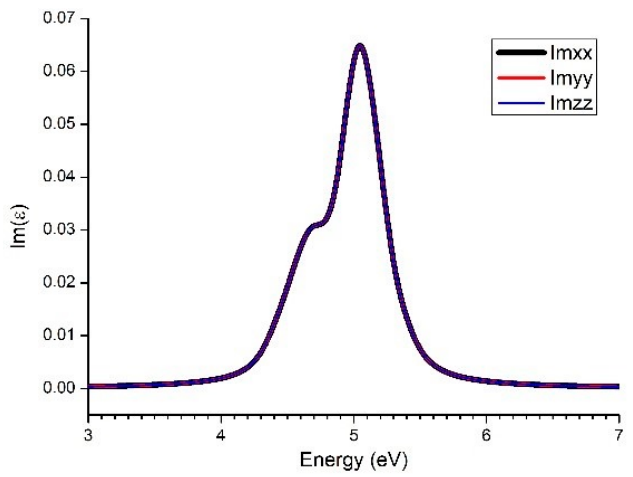
Figure 4. Imaginary part of dielectric function of pure YAG.